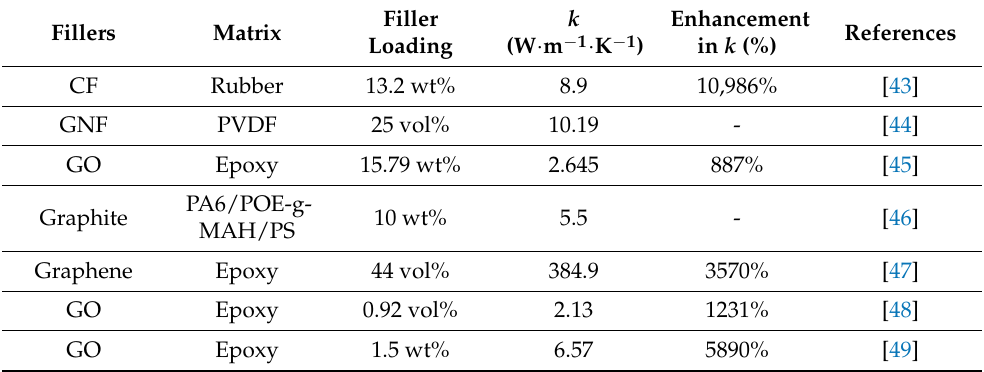
Table 3. Thermal conductivity ( k ) values of various polymer composites with vertically aligned carbon